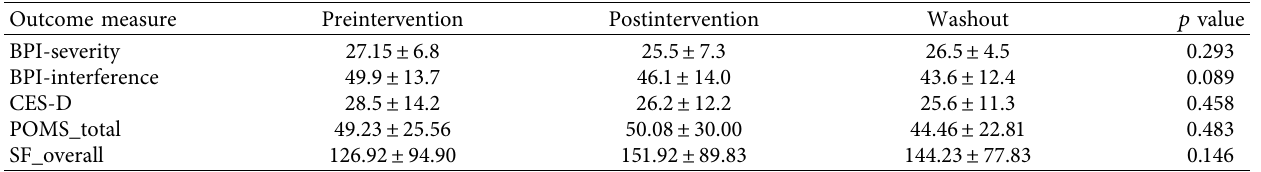
Figure 1: Subject-by-subject analysis of pain interference and mood in response to the intervention. (a) Line graph depicting the subgroup of patients that demonstrated improvements in BPI from preintervention to postintervention. (b) Subgroup of patients that demonstrated adverse BPI from preintervention to postintervention. (c) Subgroup analysis of patients that demonstrated improvements in CES-D from preintervention to postintervention. (d) Subgroup of patients that demonstrated adverse CES-D from preintervention to postintervention. ∗ p < 0 . 05. Table 2: Comparison of mean scores across time for all patients ( n �